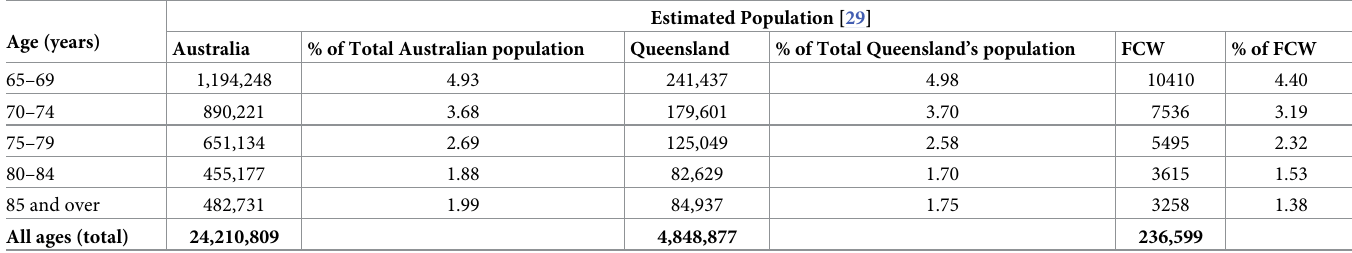
Table 1. Estimated resident population of FCW region, by age group at 30 June 2016.